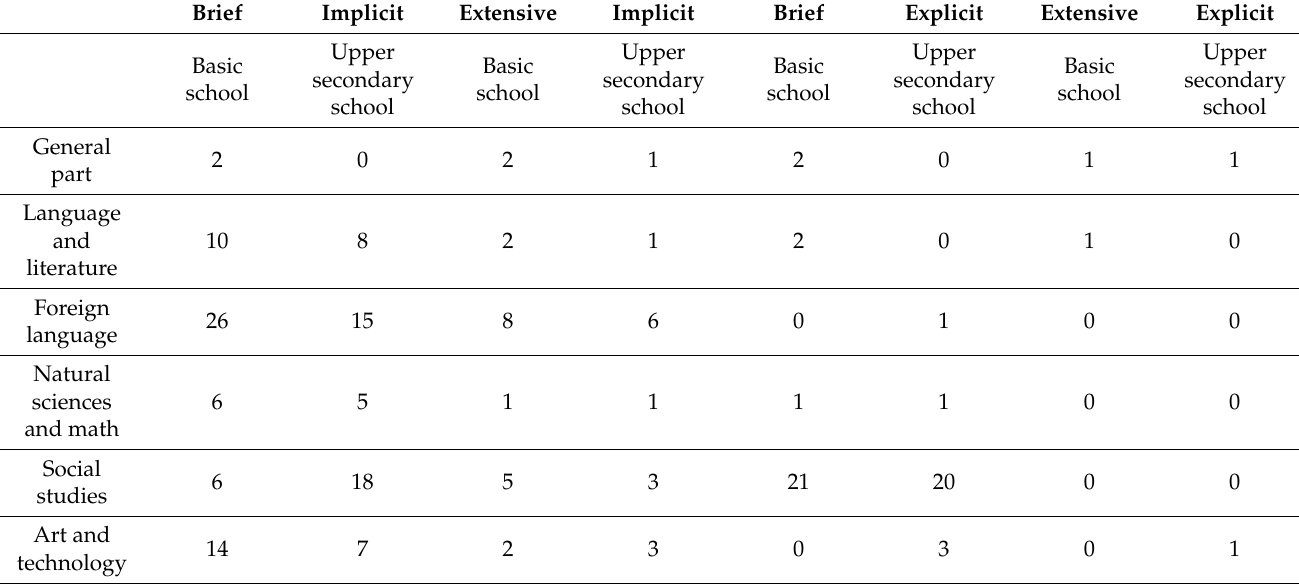
Table 2. Elements of religious literacy according to the educational model of religious literacy (Levander and Mikkola